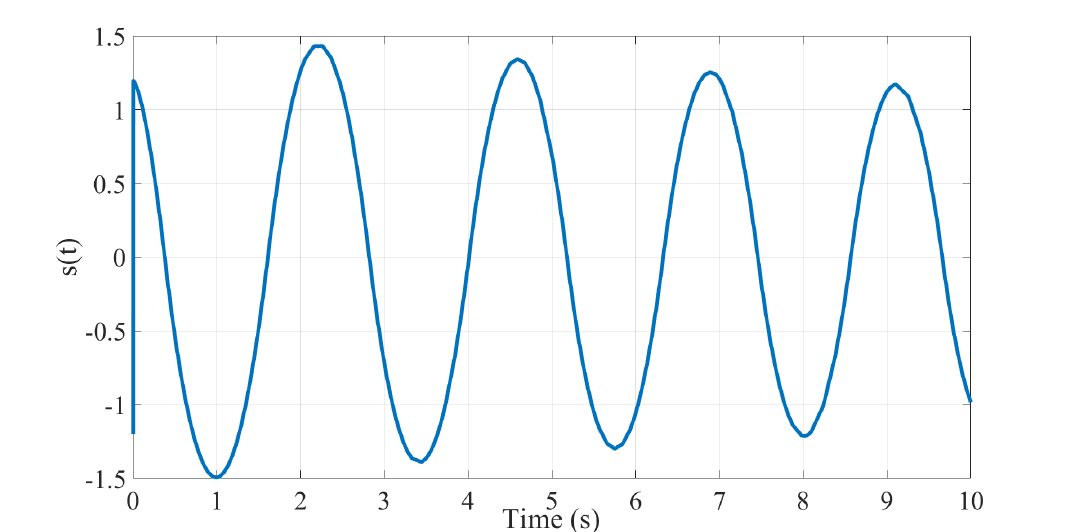
Figure 17. Sliding surface STA and constant